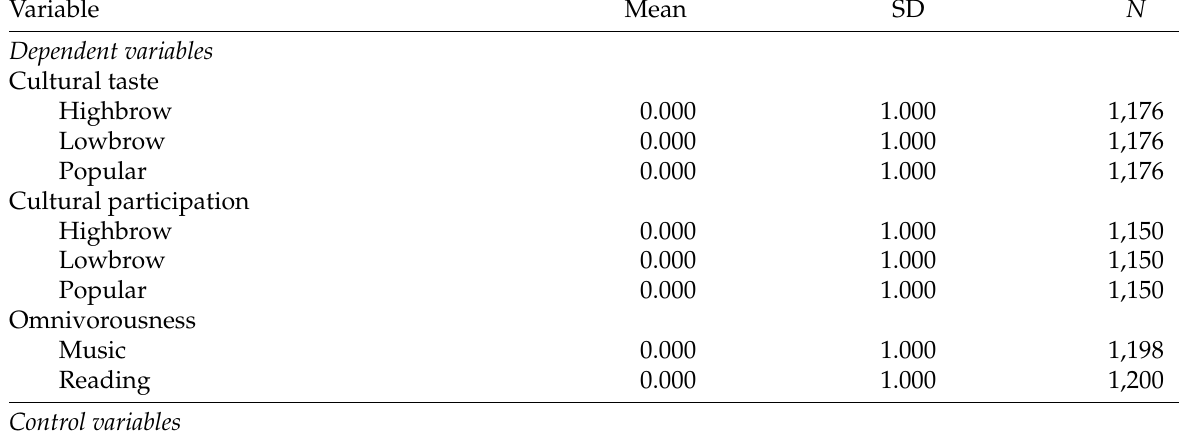
Table 2: Descriptive statistics: means and standard deviations